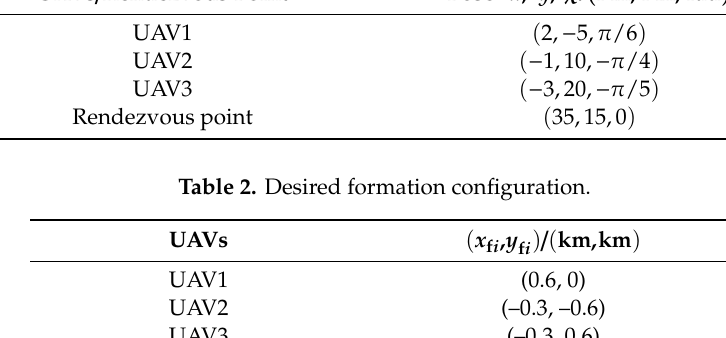
Table 1. Poses at UAVs’ starting points and rendezvous points (2-D).